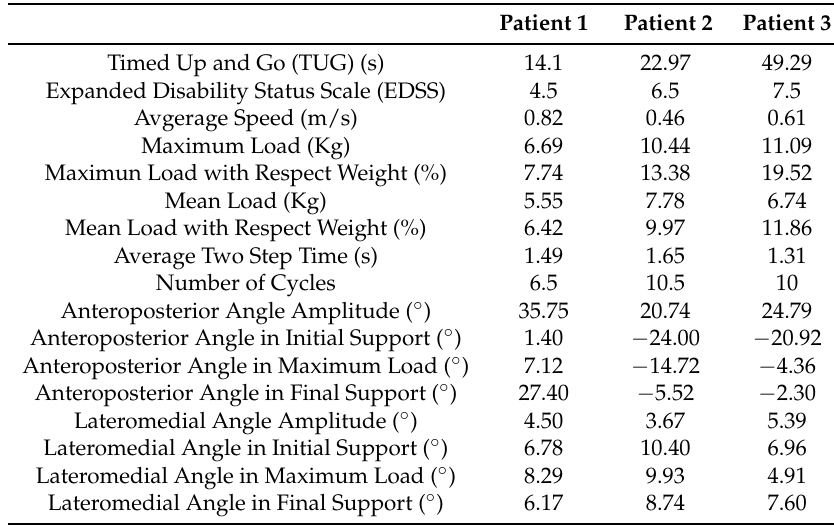
Table 8. Exploratory Study-Case